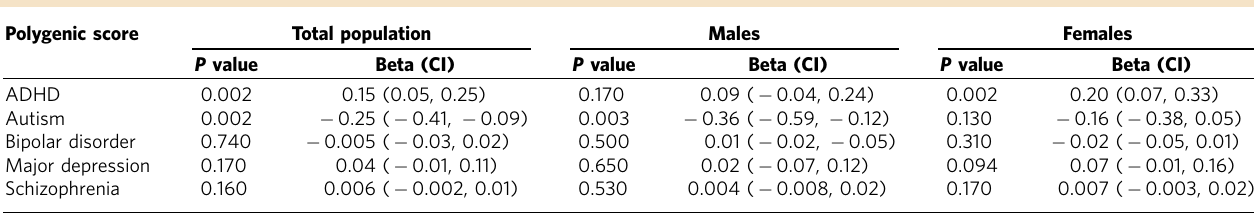
Table 1 | Association between polygenic risk scores and number of children. Total population Males FemalesPolygenic score